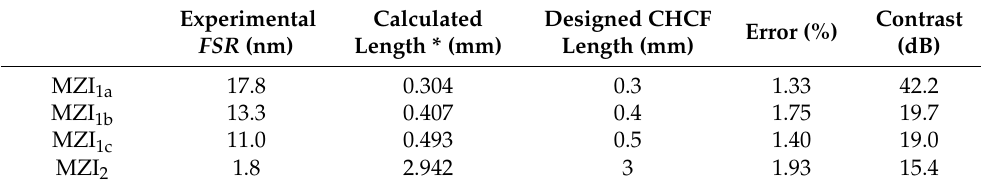
Table 1. Characteristics of the